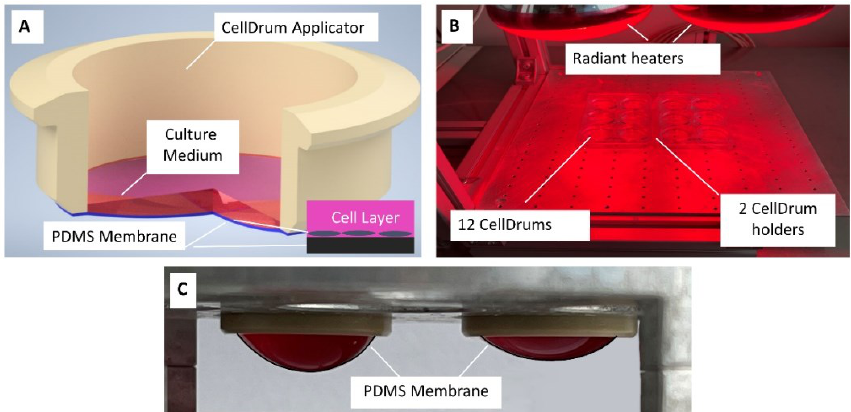
Figure 1. Scheme: PDMS membrane fabrication and testing setup. ( A ) Single CellDrum with PDMS membrane (black, enlarged inset), cells (gray, enlarged inset) with culture medium (magenta). ( B ) CellDrum membrane curing with heat lamps ( C ) Deflection of two membranes under different liquid loads with 2 mL ( left ) and 1 mL ( right ) cell culture medium .